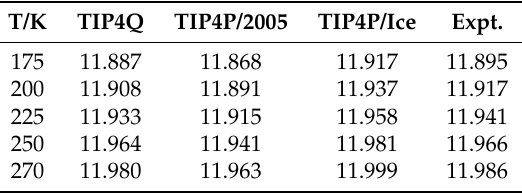
Figure 5. Unit lattice length as a function of temperature for the combinations 2005-2, Q-2 and Ice-2 in Table 1 and experimental data. Table 2. Unit cell length (in Å) as a function of temperature, under a pressure of 30 bar. The values for TIP4P/2005 are taken from Reference